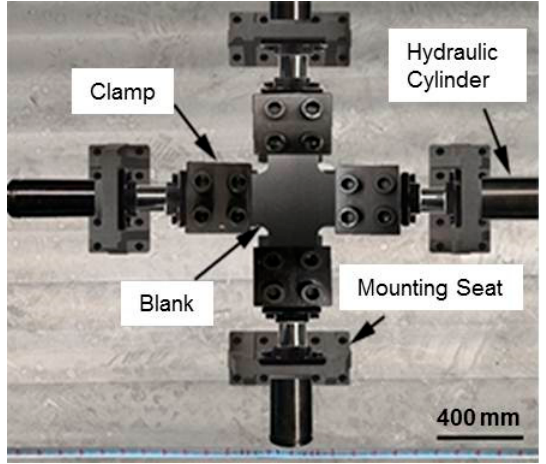
Figure 5. Cross stretching experiments.